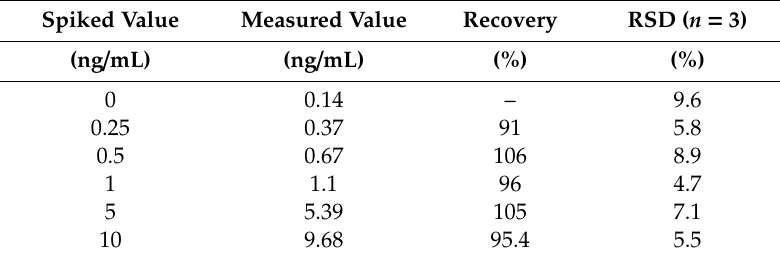
Table 2. HBsAg recoveries in serum samples using the